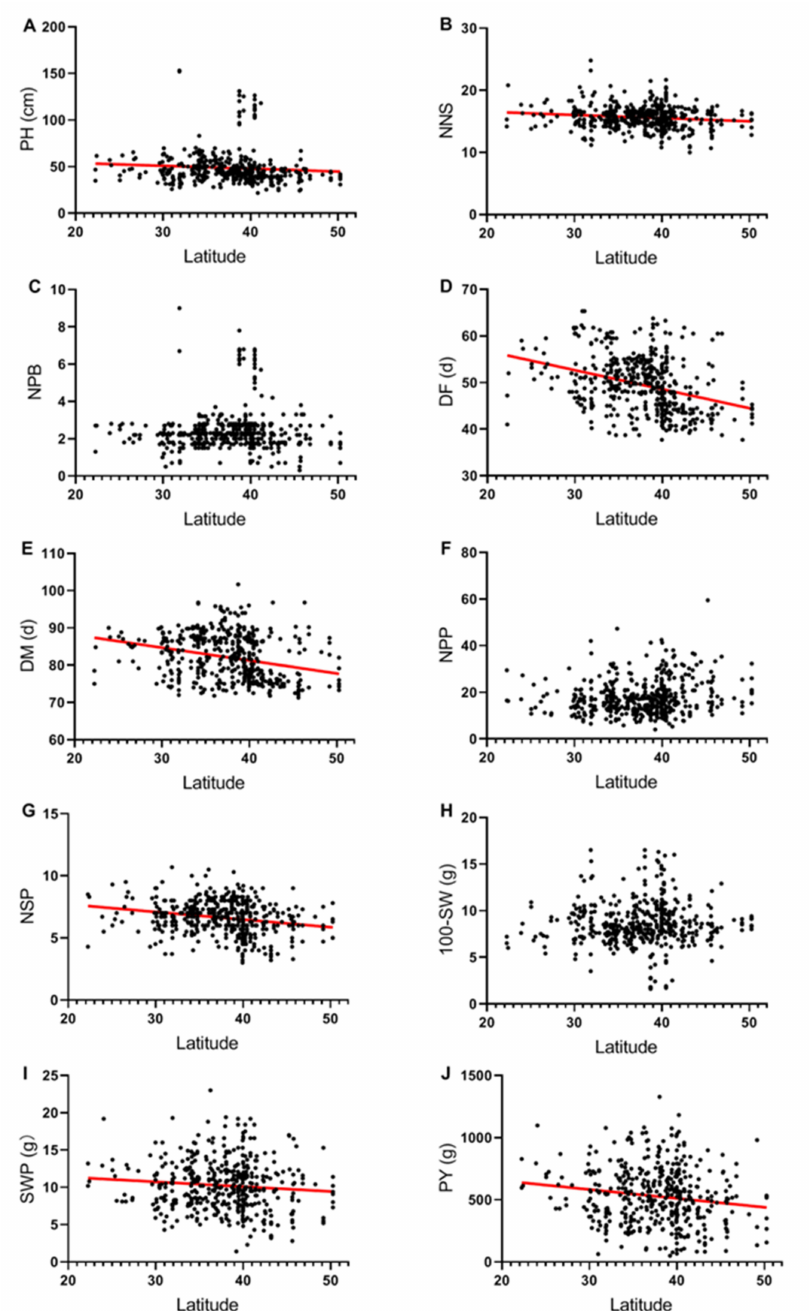
Figure 1. Relationship between latitude of the collection site and plant height ( A ), nodes number of the main stem ( B ), number of plant branches ( C ), days to flowering ( D ), days to maturity ( E ), number of pods per plant ( F ), number of seeds per pod ( G ), 100-seed weight ( H ), seeds weight per plant ( I ), and plot yield ( J ). Regression lines were drawn when there was a significant effect ( p <